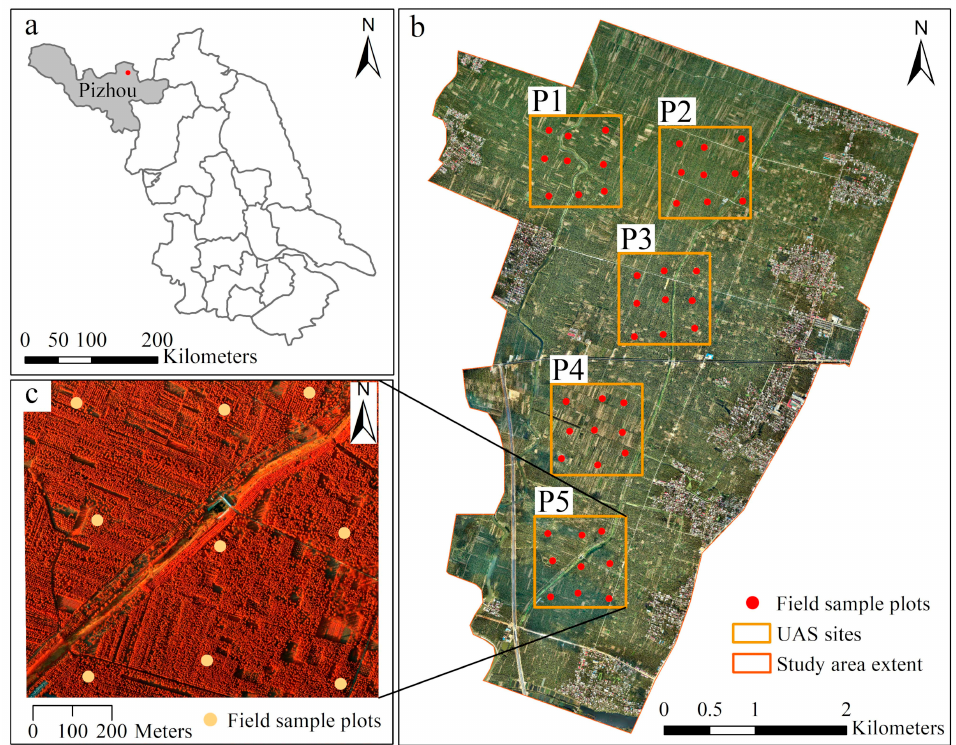
Figure 2. ( a ) Location of the Ginkgo planted forest in Pizhou city, Jiangsu province; ( b ) the mosaicked UAS imagery of study site with a true color composition and the distribution of UAS inventory plots (1 × 1 km 2 ) and sample plots (radius = 15 m); ( c ) the false color map of a UAS plot, which derived from UAS-multispectral imageries.